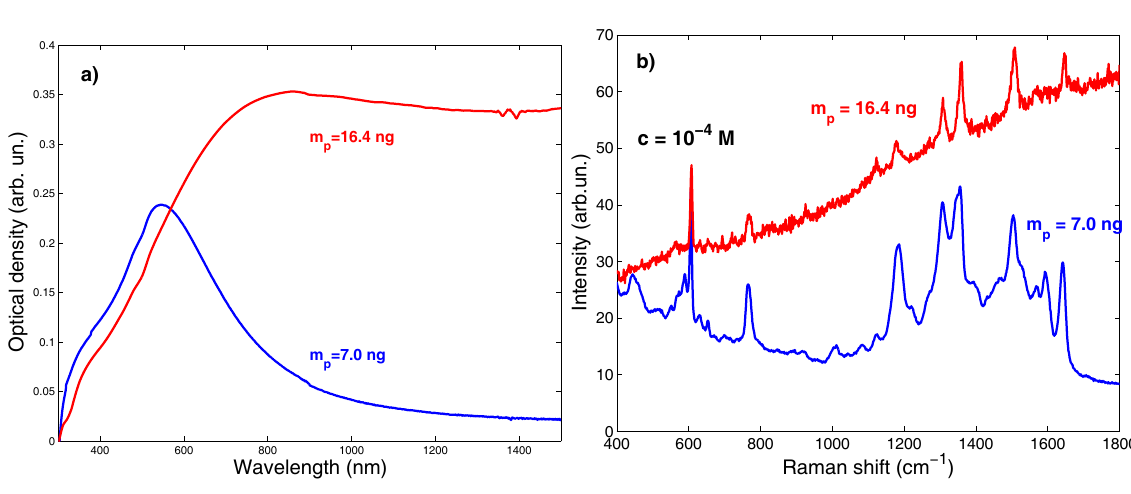
Figure 6. ( a ) UV-Vis absorption spectra of Ag samples deposited at 70 Pa of Ar, 2.8 J · cm − 2 , = 7.0 ng or m = 16.4 ng. ( b ) Raman spectra acquired on the surface 10 4 laser shots and m p p of the two samples soaked in an aqueous solution of rhodamine 6G (R6G) at a concentration c = 10 − 4